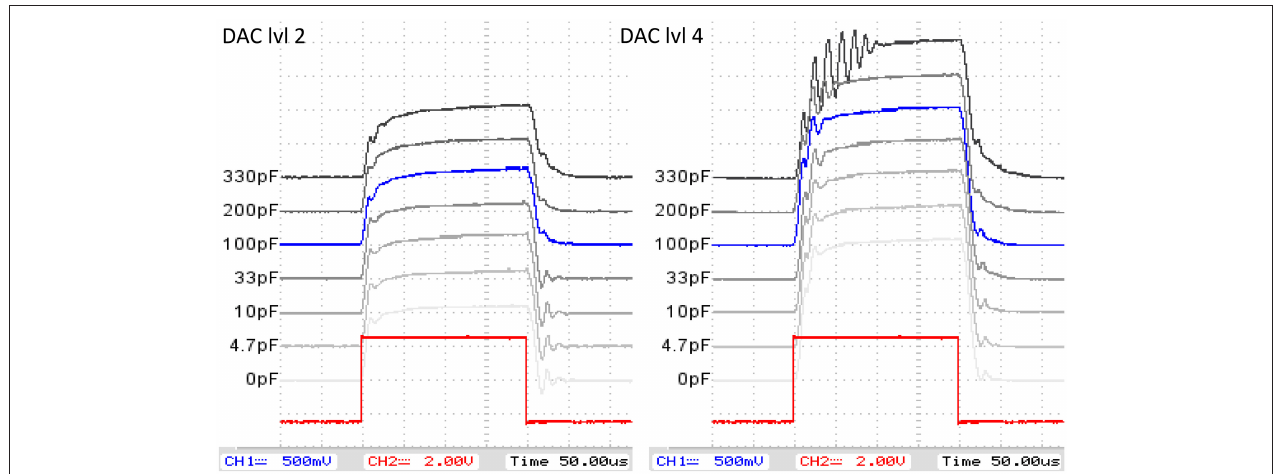
FIGURE 6 | Current regulator/moulator evaluation: 3.125kHz PWM modulation reference (red) and regulated LED currents with different decoupling capacitor values and DAC levels (blue: selected value for design).